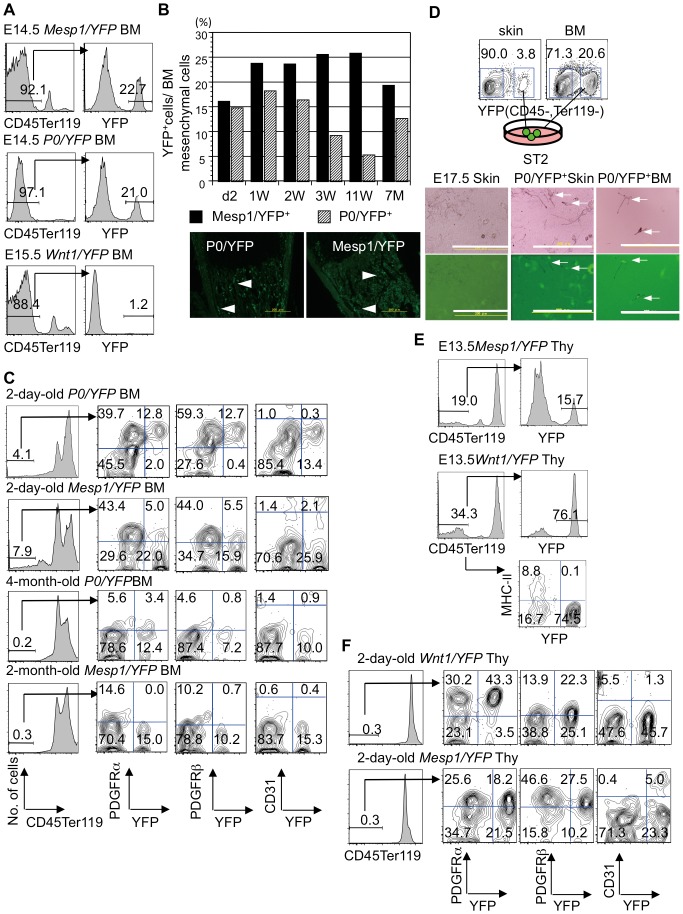
Origins and characteristics of mesenchymal cells in BM and thymus.(A) Contributions of YFP+ mesenchymal cells from Mesp1-Cre/YFP, P0-Cre/YFP, and Wnt1-Cre/YFP embryos to BM. (B) YFP+ cells from BM mesenchyme of P0-Cre/YFP and Mesp1-Cre/YFP mice from neonatal to adult stages. The mean of two independent experiments is shown. W, week; M, month. Immunohistochemistry for YFP in BM of 2-day-old P0-Cre/YFP and Mesp1-Cre/YFP mice (lower panel). White arrowheads indicate YFP+ cells in the trabecular and cortical bone. (C) Expression of YFP, PDGFRα, PDGFRβ, and CD31 on BM mesenchymal cells prepared from P0-Cre/YFP, Wnt1-Cre/YFP, and Mesp1-Cre/YFP mice. (D) Induction of melanocytes from the sorted E17.5 P0/YFP+ BM (6.5×103). The P0/YFP+ cells from the skin of the same mice (P0/YFP+ skin) and C57BL/6 mice were the controls. White arrows indicate pigmented and YFP+ melanocytes. Scale bars, 200 µm. (E) Contributions of YFP+ mesenchymal cells from Mesp1-Cre/YFP and Wnt1-Cre/YFP embryos to thymus. (F) Expression of YFP, PDGFRα, PDGFRβ, and CD31 on thymic mesenchymal cells prepared from Wnt1-Cre/YFP, and Mesp1-Cre/YFP mice. The experiments were repeated and one representative experiment is presented.